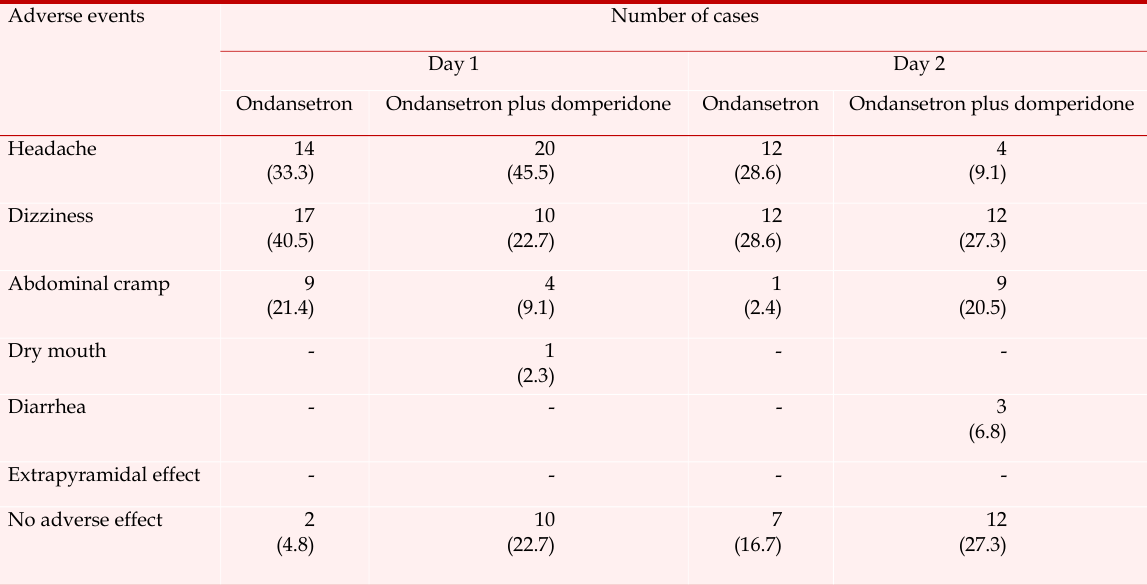
Adverse events observed in ondansetron alone and ondansetron plus domperidone treated groups Adverse